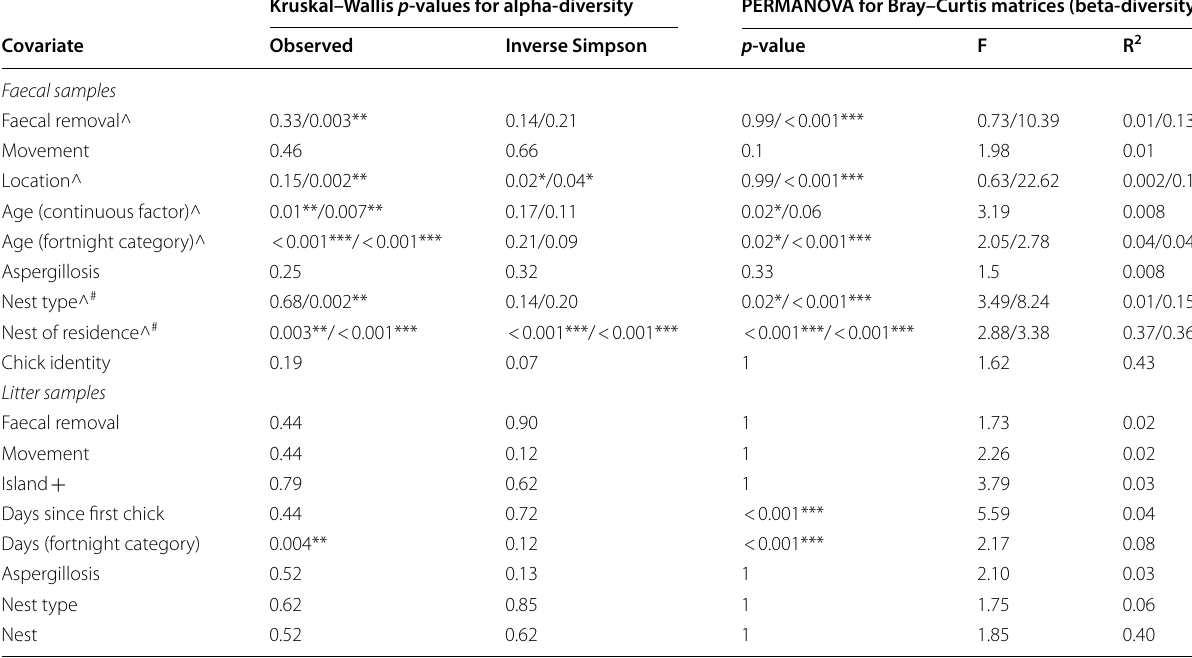
PERMANOVA was performed with 9999 permutations. Significant p -values are denoted with asterisks (* p < 0.05, ** p < 0.01, *** p < 0.001). p -values are Benjamini– Hochberg adjusted. ^ Indicates covariates with two p -values for which analyses were performed firstly without hand rearing samples, and then subsequently